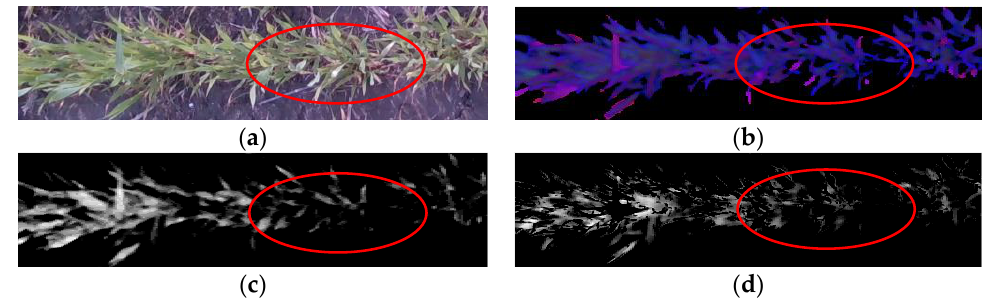
Figure 7. Soil background segmentation results: ( a ) RGB image; ( b ) crop row information extracted based on the HSI model; ( c , d ) crop row information extracted by the ExG and ExGR vegetation indices, respectively. The red oval indicates the reflective part of the leaves in the crop row.